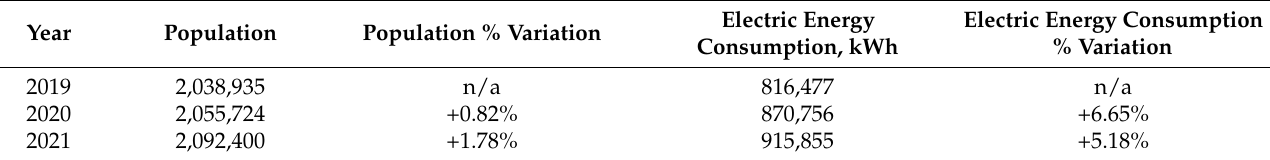
Table 4. Population dynamics and energy consumption change through 2019–2021 in the Almaty region.